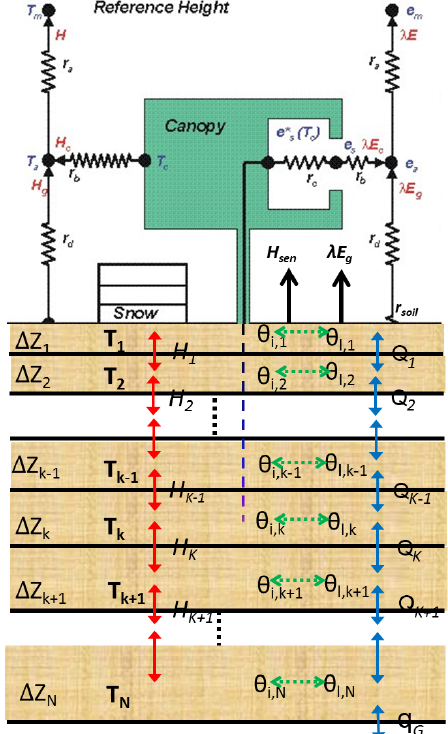
Figure 1. Schematic diagram of SSiB3-FSM. Soil temperature, soil volumetric water content and soil volumetric ice content are T , θ l and θ i , respectively. The heat and water flux between soil layers are represented by H k and Q k . The soil layer number is k , which ranges from 1 to N